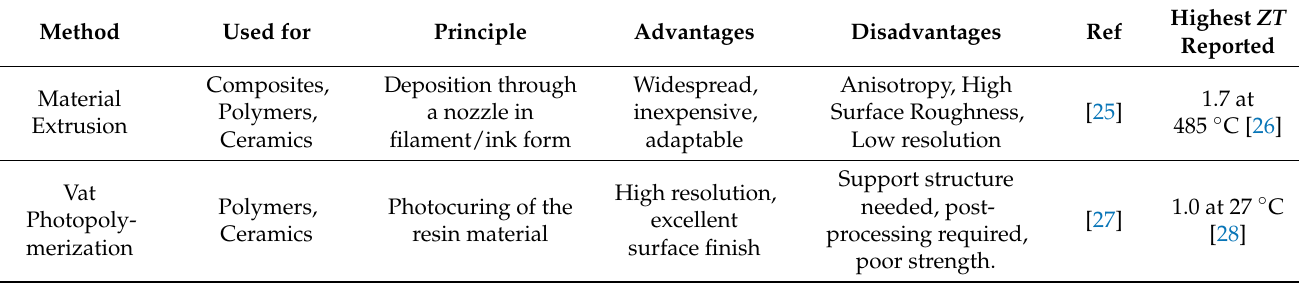
Table 1. Classification of AM methods material extrusion, material jetting, powder bed fusion, vat photopolymerization, binder jetting, direct energy deposition, and sheet lamination as per ISO/ASTM